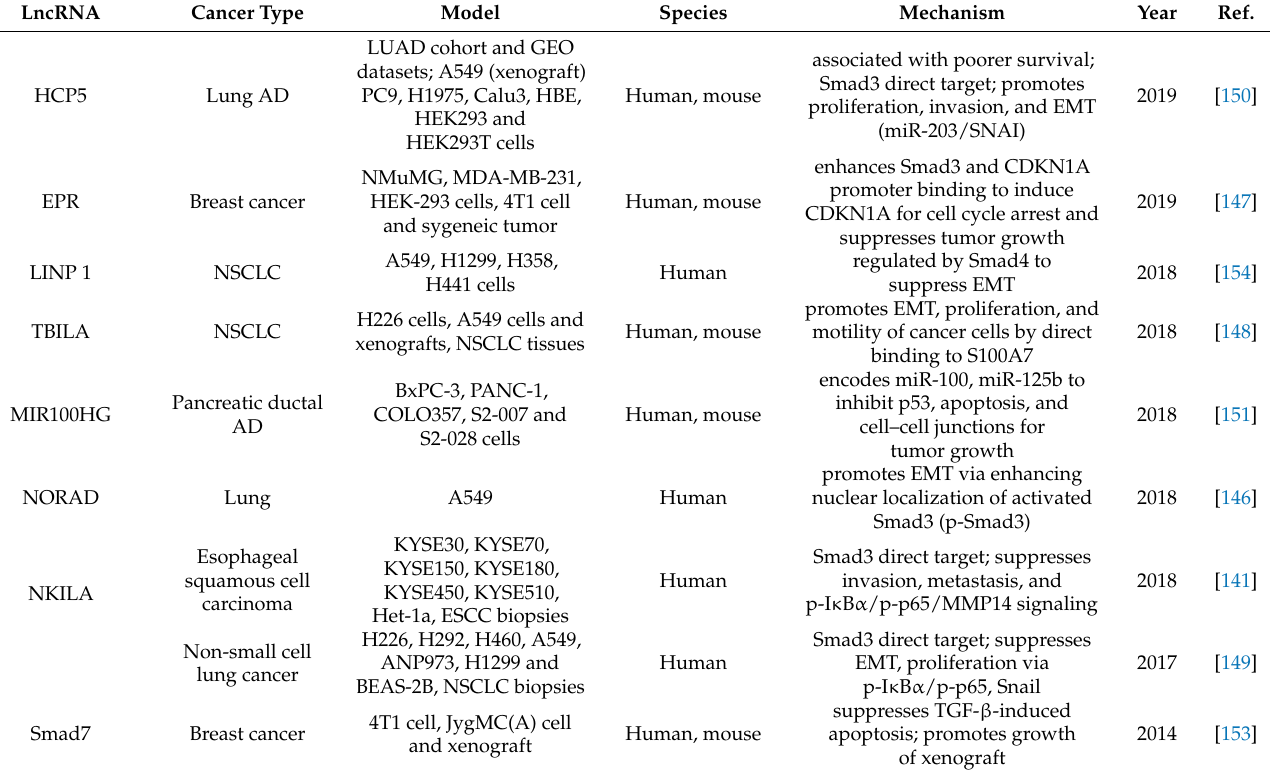
Table 4. Smad3 associated lncRNAs in